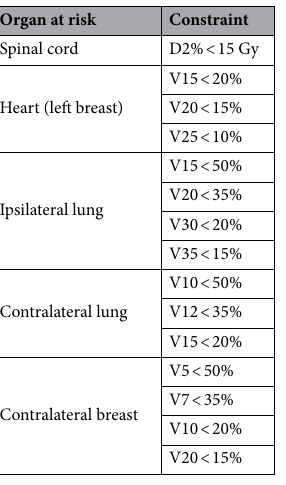
Table 1. Dosimetric constraints for organs at risk. Vx volume receiving × dose (gray); % of the organ at